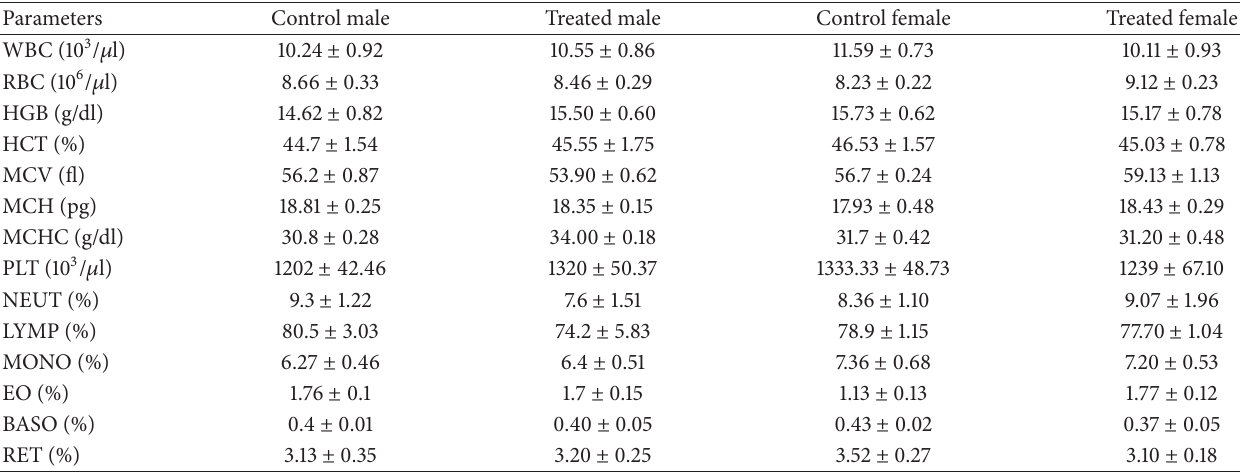
Table 5: Haematological parameters of male and female